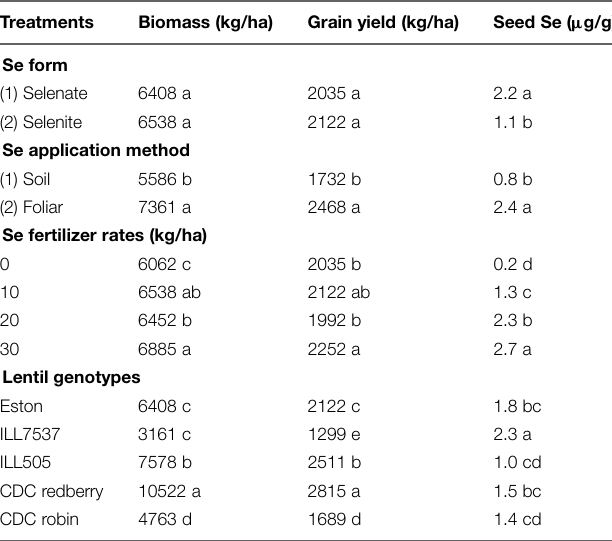
TABLE 2 | Overall effect of Se fertilizer form, application method, rate, and lentil genotype on biomass, grain yield, and seed Se concentration.